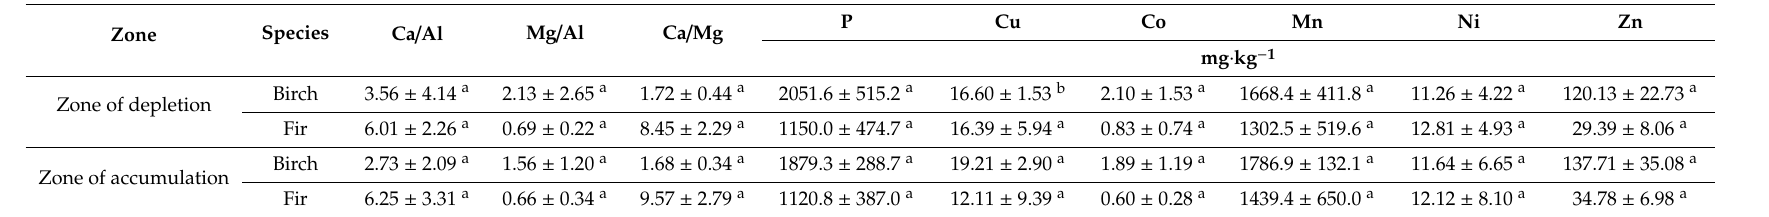
Table 5. Macro and micronutrients in the leaves of birch and needles of fir growing in di ff erent landslide zones.